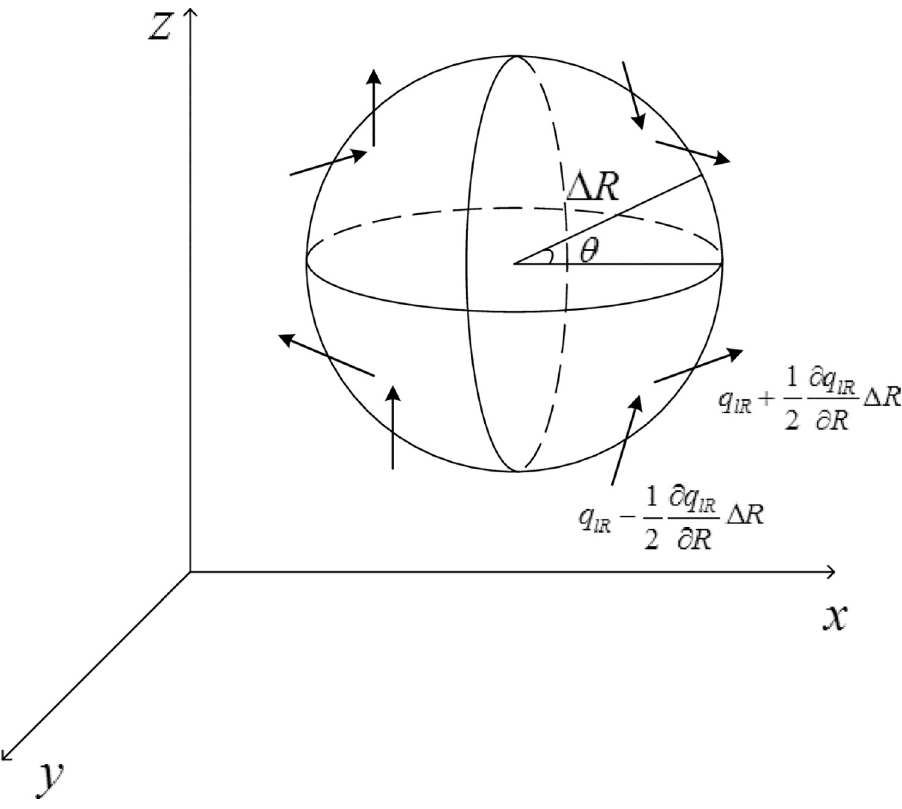
Fig 1. Differential element in rectangular